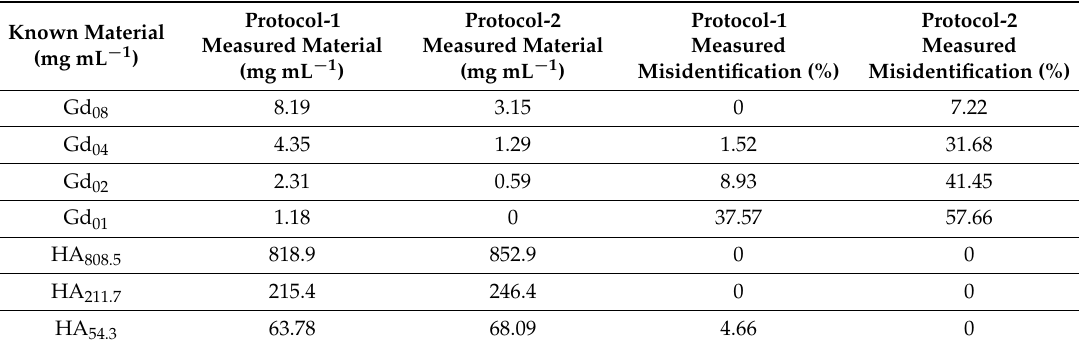
Figure 12. Relationship between known and measured concentrations of Gd ( a ), and HA ( b ). Dotted line shows the trend line. Error bars show the standard deviation of measured concentrations from their mean value i.e., 1.51 to 3.14 mg Gd/mL for gadolinium ( a ) and 23.6 to 134.6 mg HA/mL for hydroxyapatite ( b ) . Table 2. Qualitative and quantitative results summary of the Gd/HA calibration phantoms with two imaging protocols.